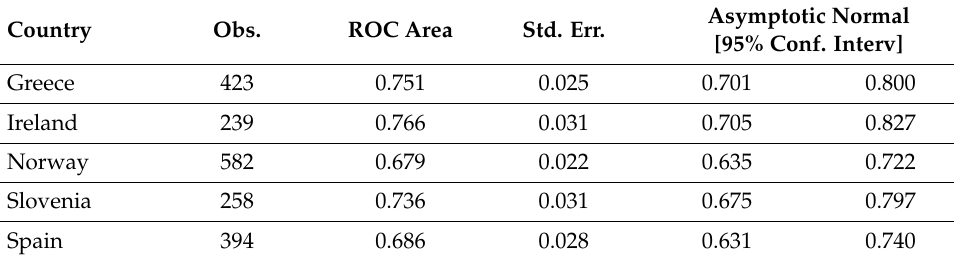
Table 4. Comparison of the ROC areas—country subsample models